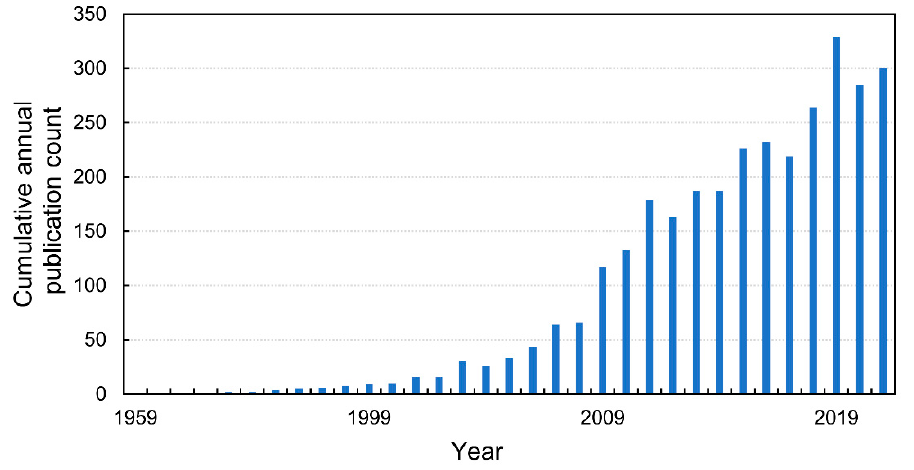
Figure 2. The cumulative annual publication count of papers on NO and seeds. Details of the search are described in the Supplementary Materials.